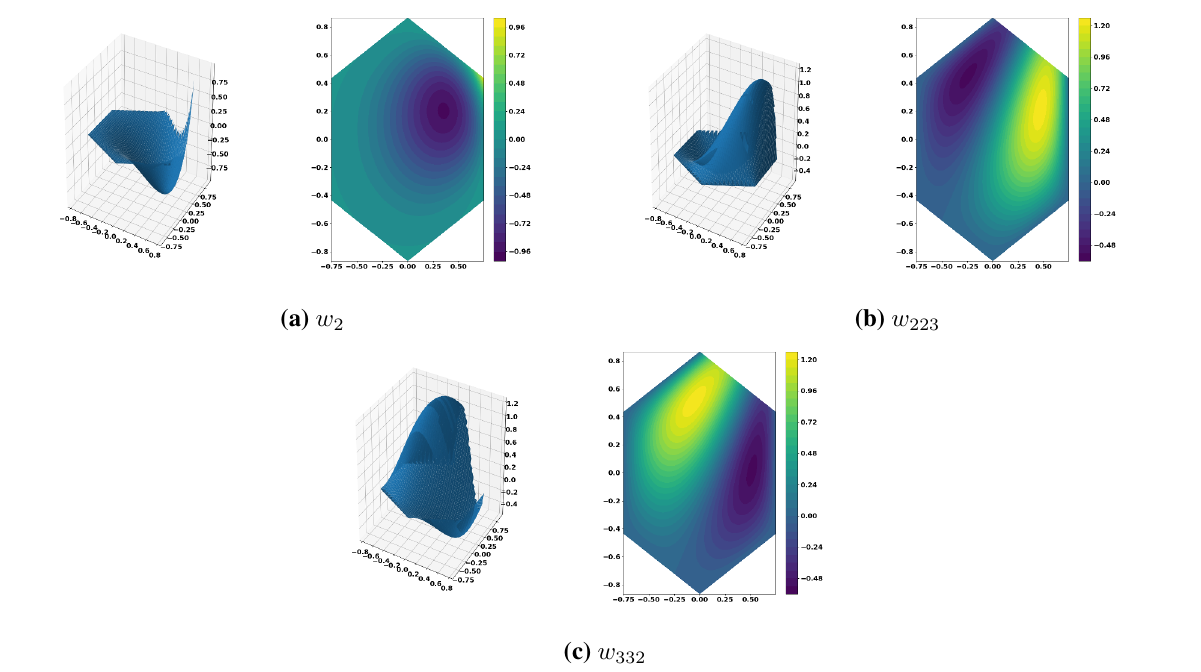
Figure 2: Example of Wachspress basis functions of order 3.